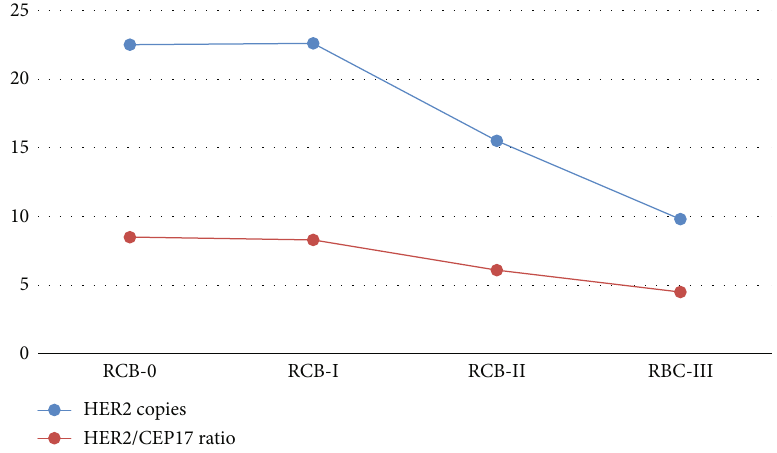
Figure 3: Mean HER2 copies and HER2/CEP17 ratios by post-neoadjuvant treatment residual cancer burden categories.